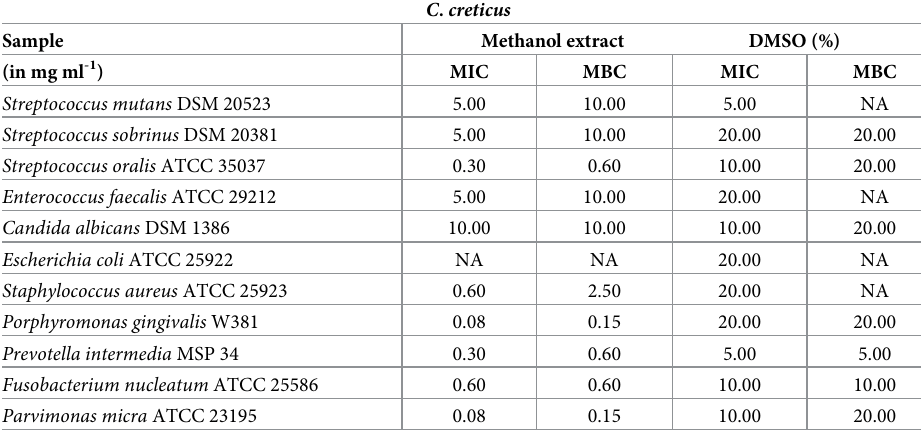
Table 7. Antimicrobial activity in mg ml -1 of C . creticus methanol extract.